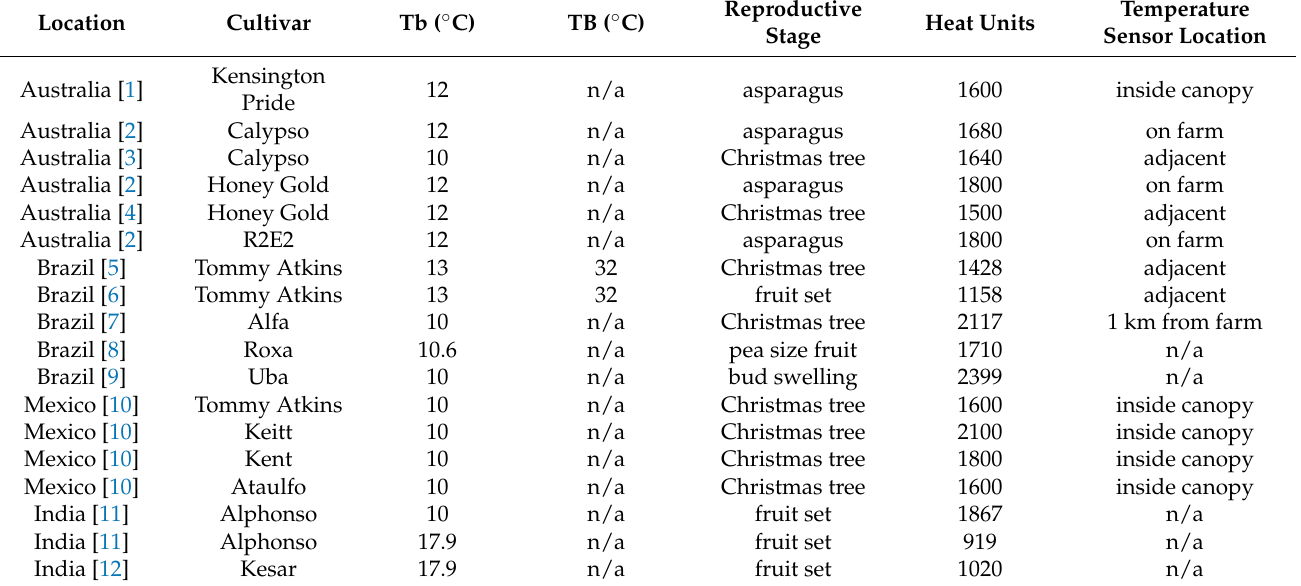
Table 1. Required heat units for fruit maturation, including upper (TB) and lower base temperature (Tb) utilized for calculation of GDD in each study, from the reproductive stages of asparagus, Christmas tree stage (2/3 flowers open, with 1/3 still not open on panicle tip) and fruit set. n/a is not applicable. The sensor location ‘adjacent’ refers to sensor placement adjacent to the orchard